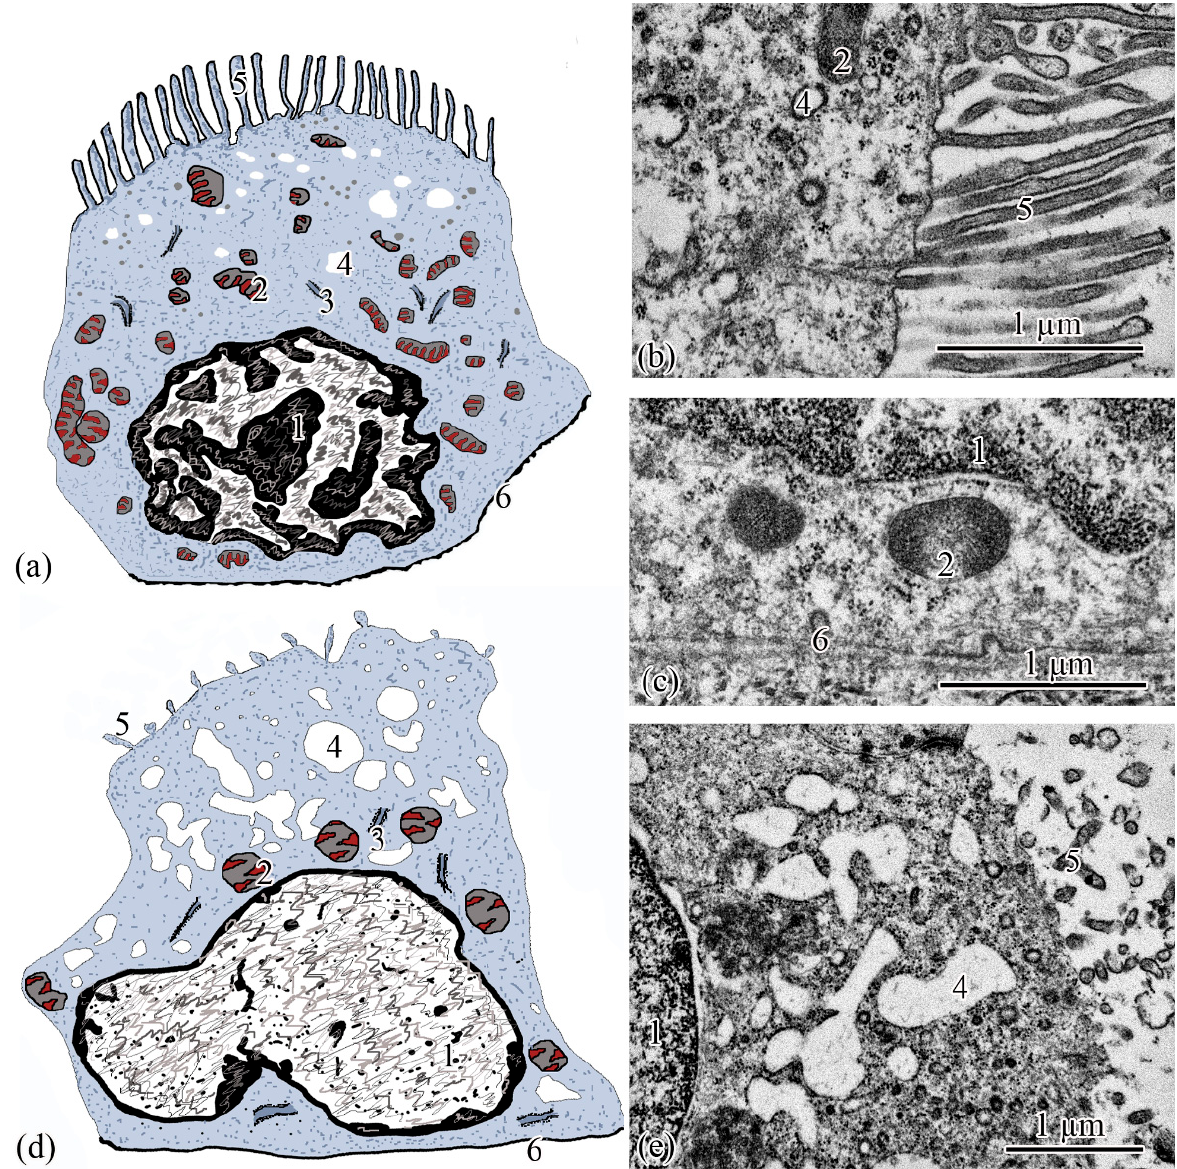
Figure 5. Ultrastructure of the intermediate tubule. Type I epithelial cell scheme ( a ); apical part of type I epithelial cell ( b ); basal part of type I epithelial cell ( c ); type II epithelial cell scheme ( d ); apical part of type II epithelial cell ( e ). Cell units: nucleus (1), mitochondria (2), cisterns of the rough endoplasmic reticulum (3), vesicle (4), microvilli (5), basement membrane (6). The wall of the distal tubule is formed by the highest cuboidal epithelium in the nephron, consisting of two types of epithelial cells (Figure 6a,c). The width of the basement membrane throughout this region of the nephron is 0.27 ± 0.07 µ